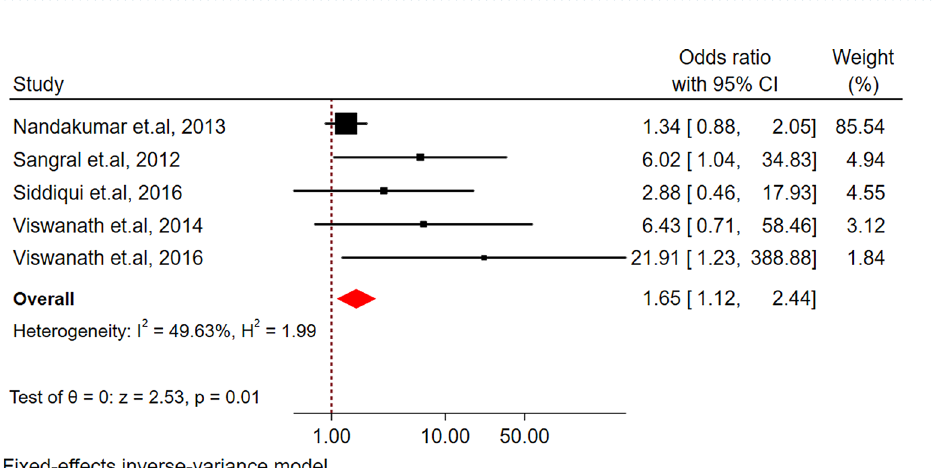
Fig. 3. There was moderate heterogeneity ( I 2 = 49.63%) across the pooled studies. Multi drug‑resistant tuberculosis. The pooled effect size demonstrated a nonsignificant difference in risk for MDR-TB between diabetic and non-diabetic TB participants (Fig. 4).